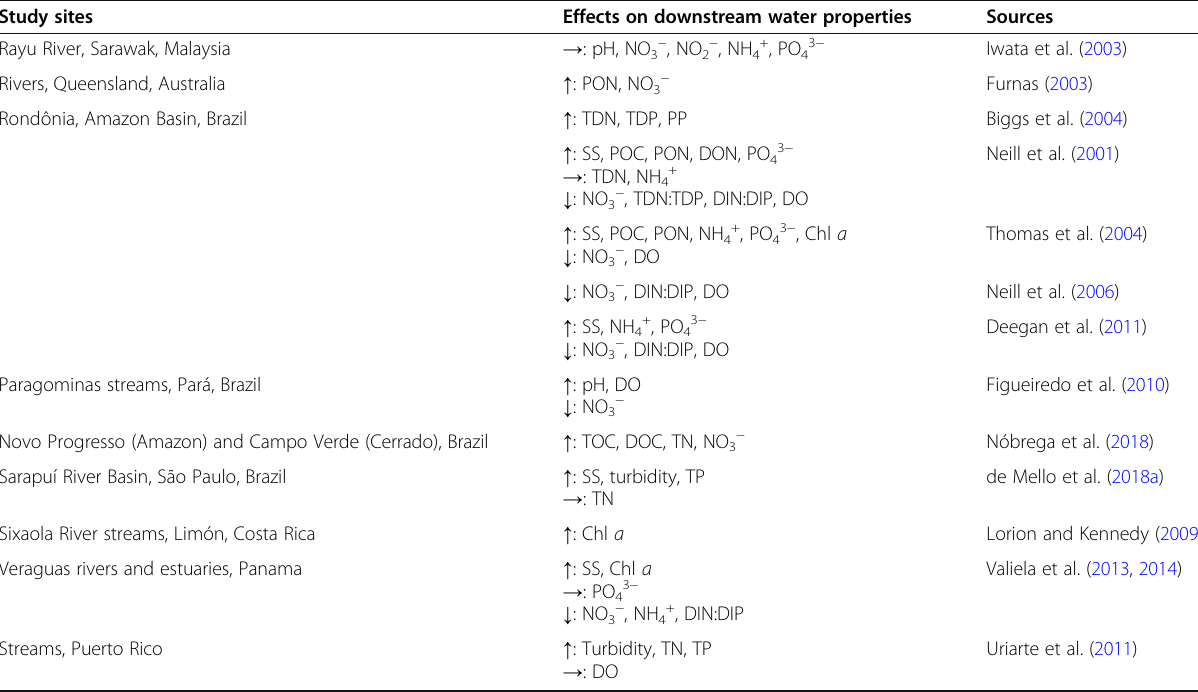
Table 3 A summary of the effects of the conversion of primary forest to pastures and ranches on the downstream riverine and estuarine water properties. The arrows before the water properties indicate that the subsequent water properties increased ( ↑ ), decreased ( ↓ ), or did not change ( → ). See the list of abbreviations for the water